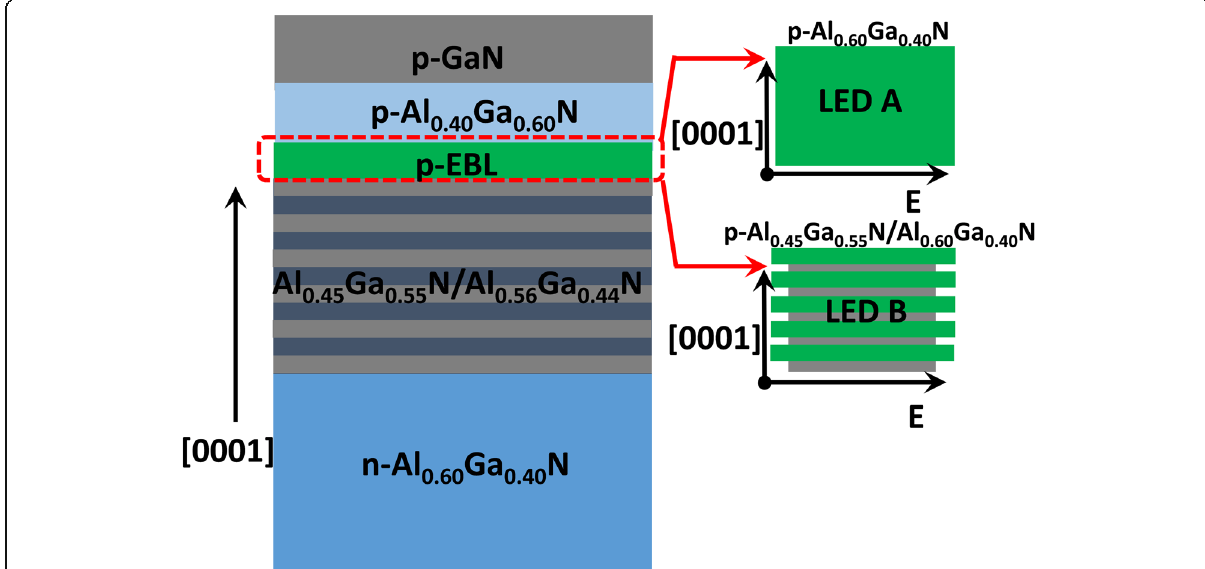
Fig. 1 Schematic architectural structures for the studied LEDs. The sketched energy band diagrams for the two p-EBLs are also provided: LED A has the p-Al 0.60 Ga 0.40 N-based EBL and LED B has the p-Al 0.45 Ga 0.55 N/Al 0.60 Ga 0.40 N superlattice EBL. The p-Al 0.45 Ga 0.55 N/Al 0.60 Ga 0.40 N superlattice EBL is specifically designed such that it initiates the thin p-Al 0.45 Ga 0.55 N layer so that the interface for the p-Al 0.45 Ga 0.55 N/Al 0.56 Ga 0.44 N last quantum barrier possesses negative polarization interface charges. E means energy level.